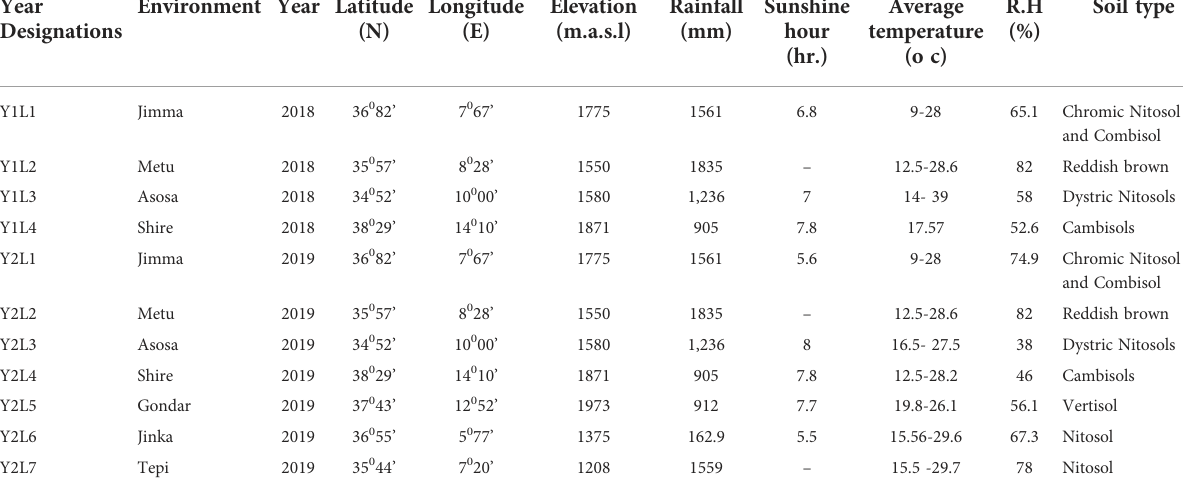
TABLE 2 The eleven sites and soil attributes used for evaluation across the country are described. Year Environment Year Latitude Designations